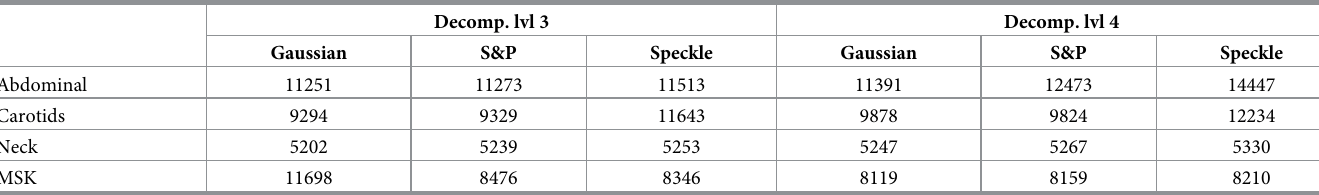
Table 5. The results of computational complexity of Symlet wavelets for various type of noise and used datasets. Time is in